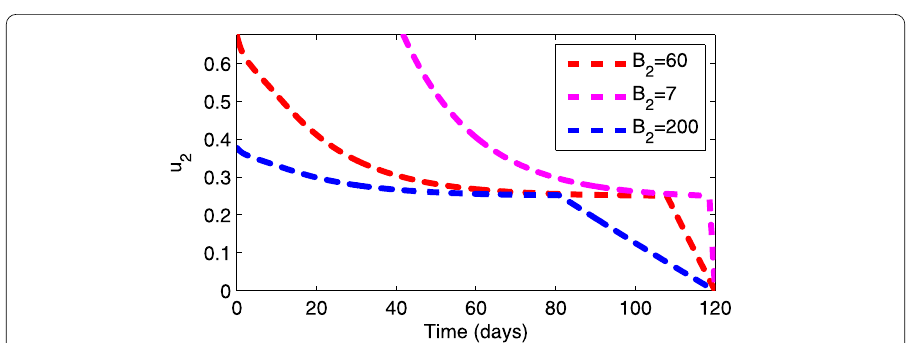
Figure 16 Plot of different weight constants on the control u 2 .